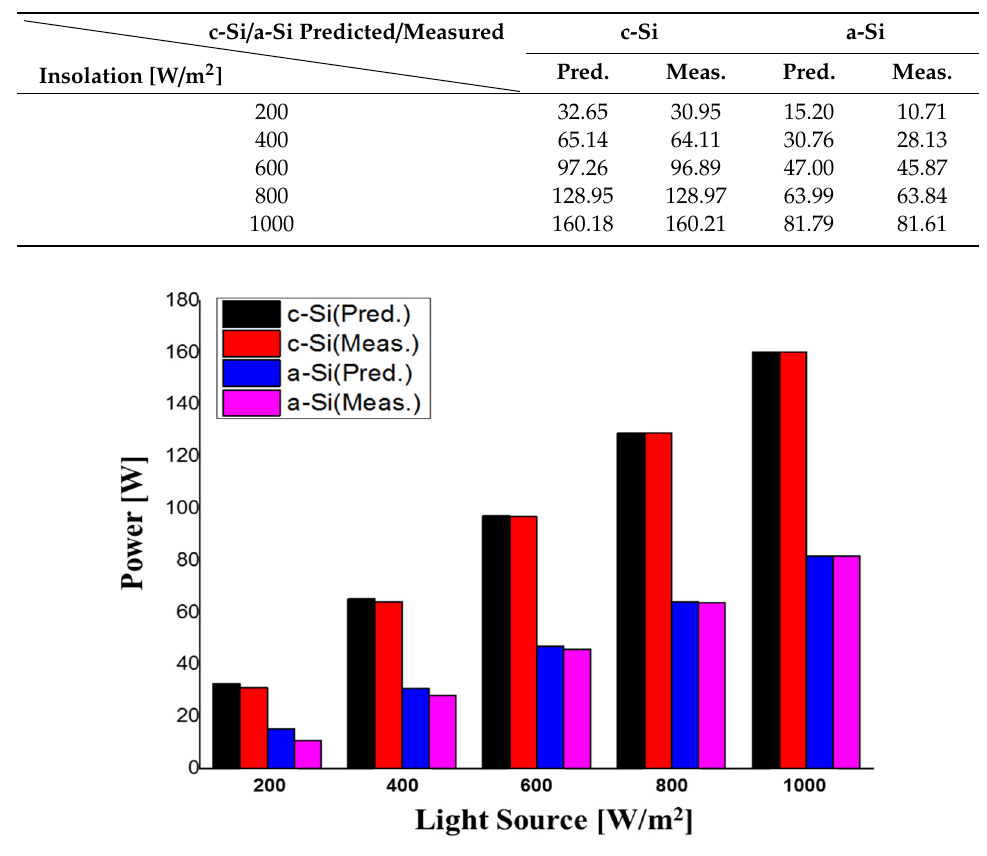
Figure 9. Comparison of the generated power of the PV modules between the laboratory test (measured) and Sandia model (predicted).